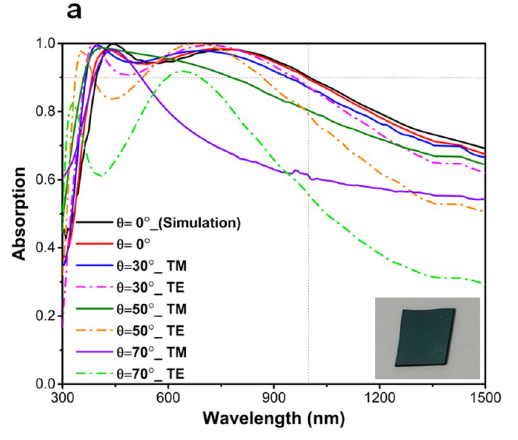
Figure 4. The simulation and measurement spectra for normal and oblique angle incident light with different polarizations of TE and